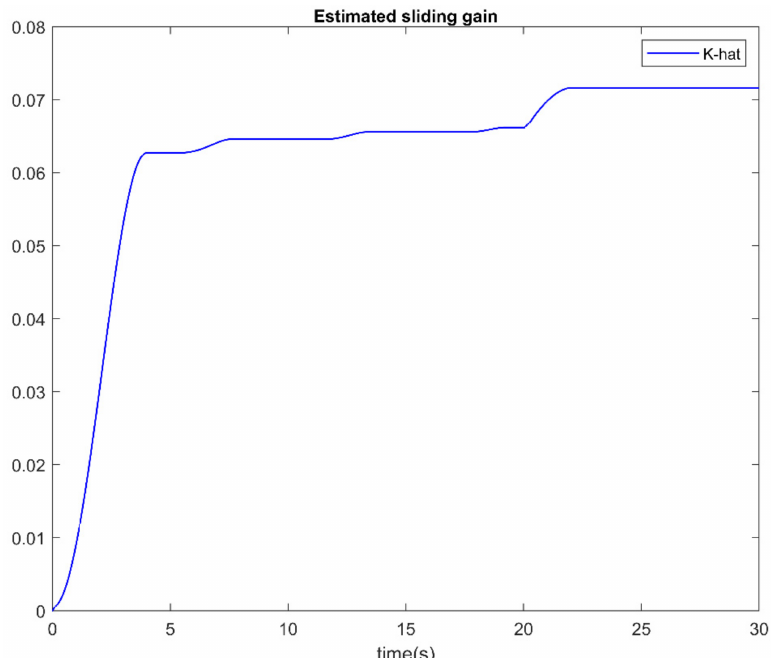
Figure 7. Control input at each joint.